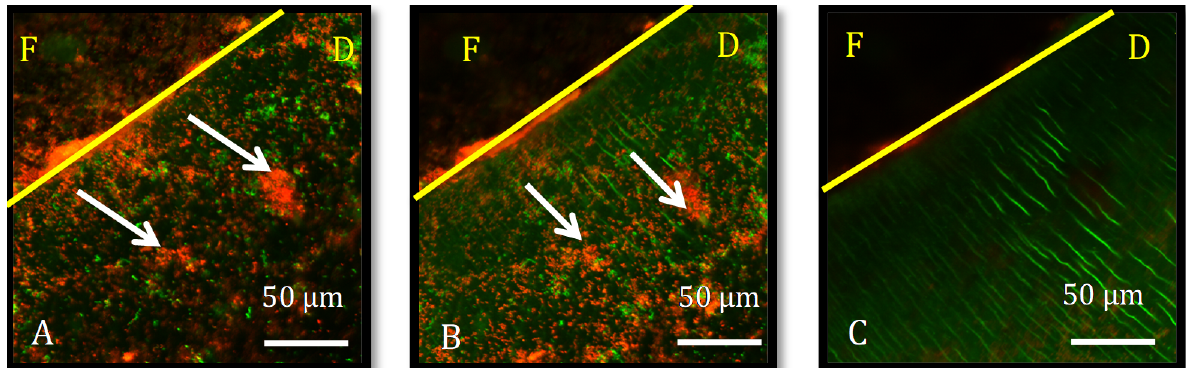
Figure 1. Representative confocal Z-stack images processed by IMARIS, of a specimen from group AH, aged for 30 days in PBS. The yellow line marks the interface between root canal filling (F), and dentin (D), at depth 0 µm ( A ) and 5 µm ( B ). White arrows show bacterial biofilm. At 13 µm ( C ) there were no visible biofilms. Live/Dead kit, green cells are live while red cells are dead.